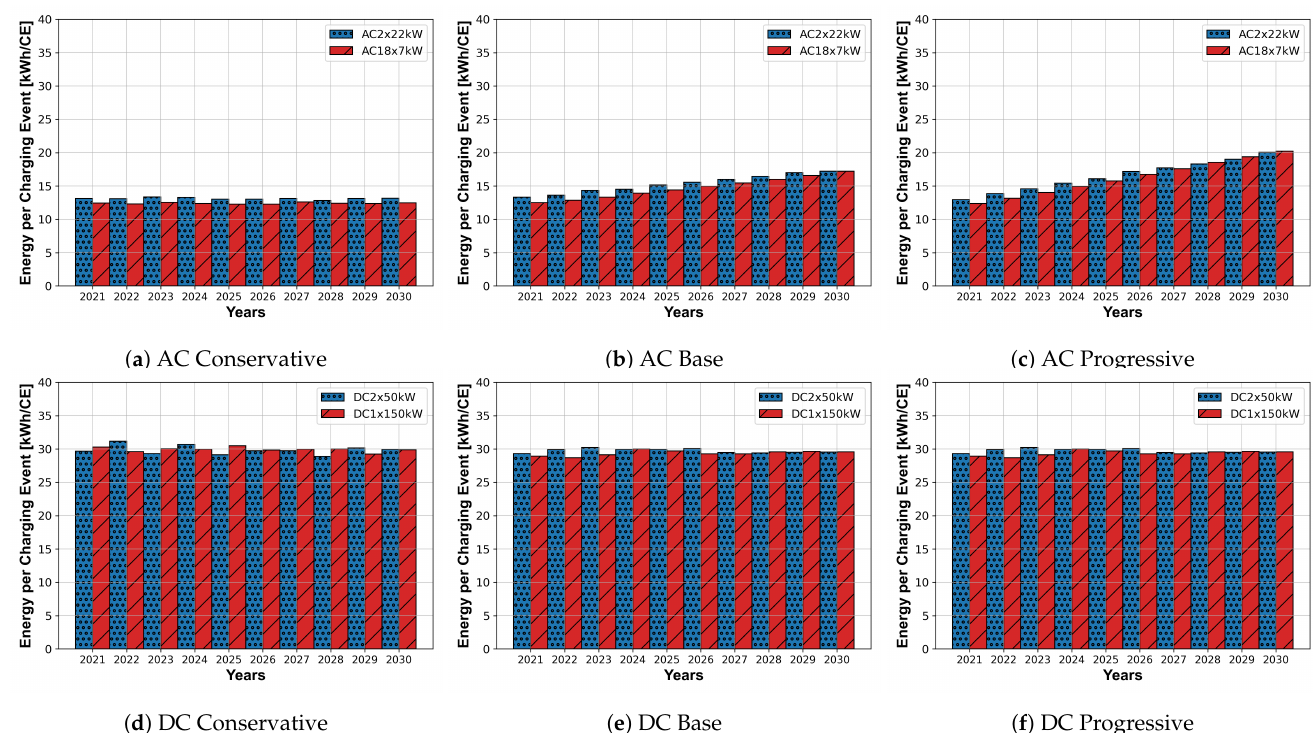
Figure A3. Average Transmitted Energy per Charging Event.